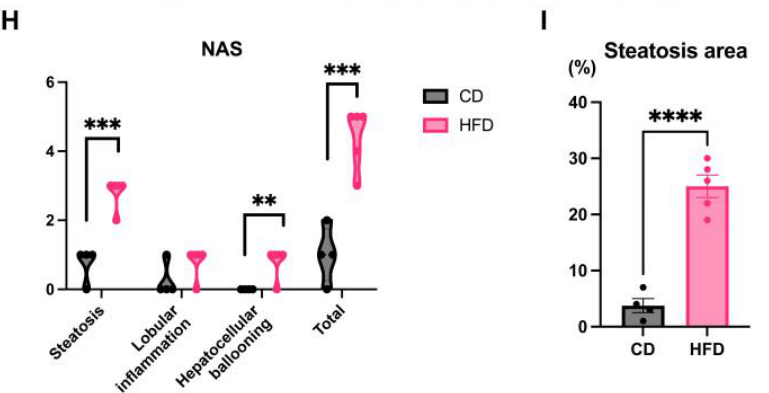
Figure 1. Mouse model of high-fat diet (HFD) induced nonalcoholic fatty liver. ( A ) Body weight gain of HFD- and control diet (CD)-fed mice. ( B ) The concentration of blood fluorescein isothiocyanate (FITC)-dextran following oral administration to mice. ( C – F ) Liver weight, Liver/body weight ratio, serum total cholesterol (TC), and serum aspartate aminotransferase (ALT) of the HFD and CD groups. ( G ) Hematoxylin and eosin (H&E) staining of livers from HFD- and CD-fed mice. Scale bar: 100 µ m. Red Arrowheads show ballooning cells. ( H ) The non-alcoholic fatty liver disease activity score (NAS) is the sum of the lobular inflammation, ballooning, and steatosis scores according to the H&E score. ( I ) Area of liver steatosis of HFD- and CD-fed mice. All data represent the mean ± standard error of the mean. Student ’ s t -test, ** p < 0.01, *** p < 0.001, **** p < 0.0001. n = 4, CD group; n = 5 HFD group.